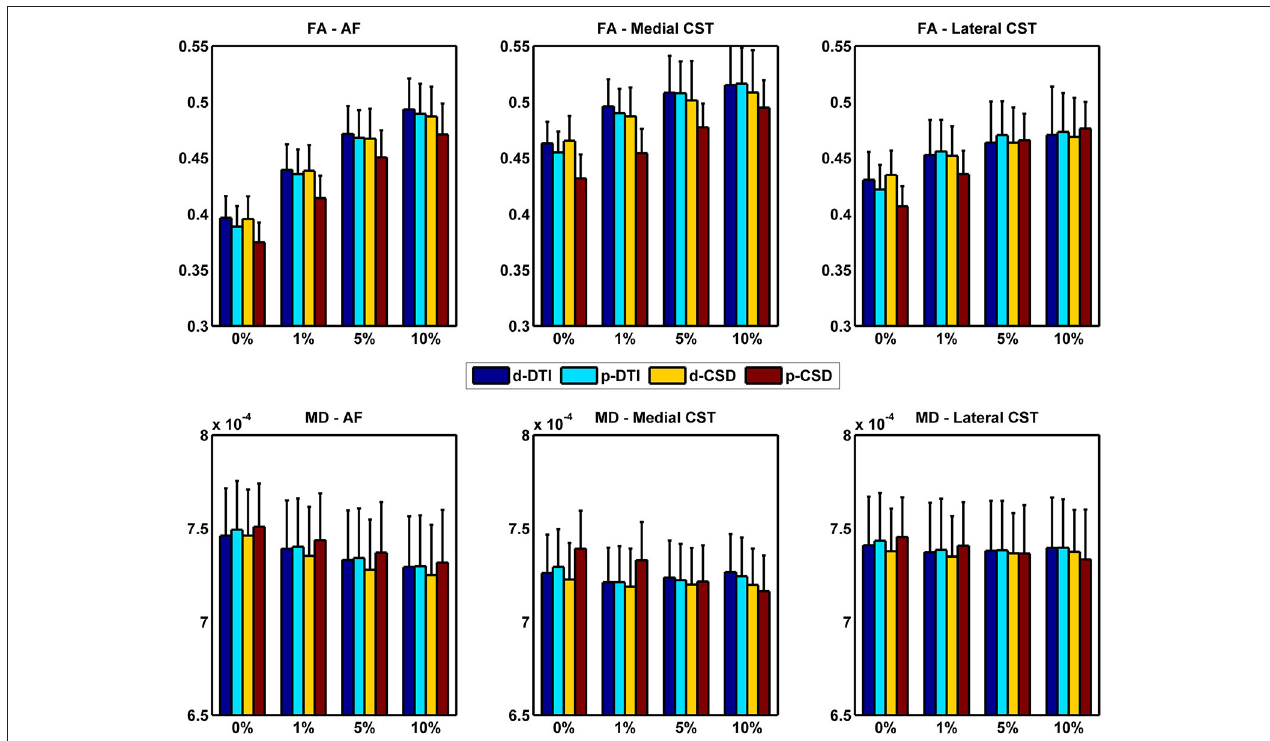
Table 3 together with the percentages of voxels involved in the